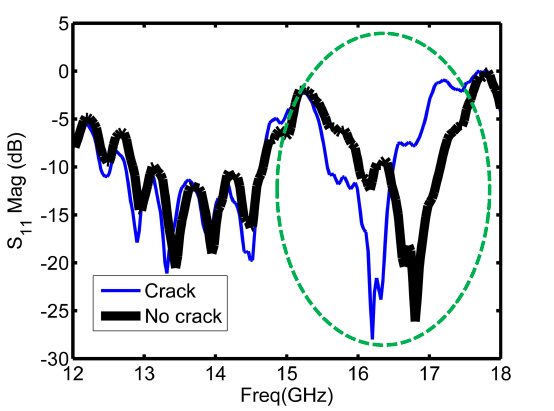
Figure 4. Reflection coefficient magnitude plots from healthy and unhealthy metallic